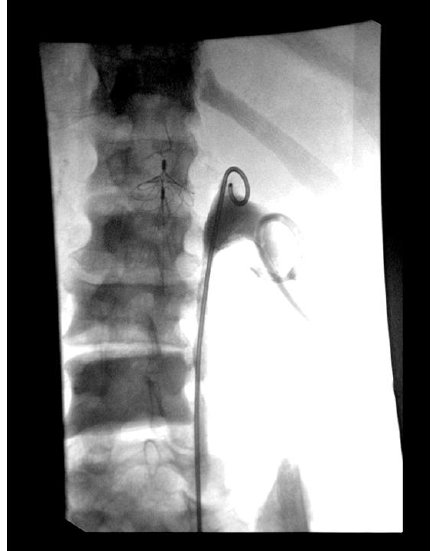
FIGURE 1. Case 1. Stent obstruction at 63 days; antegrade nephrostogram with absence of antegrade contrast flow.